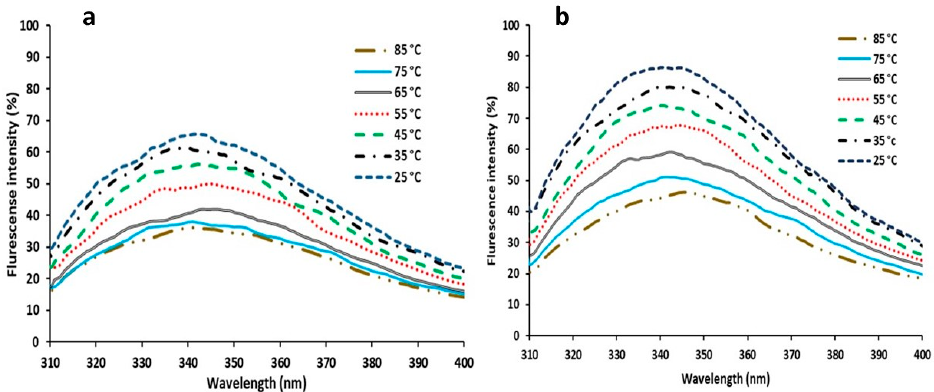
Figure 13. Internal fluorescence spectroscopy of naked and immobilized enzymes. ( a ) shows the extent to which the structure of the naked Uox can be retrieved. ( b ) also shows the return of the structure of the immobilized enzyme under the thermal reduction.